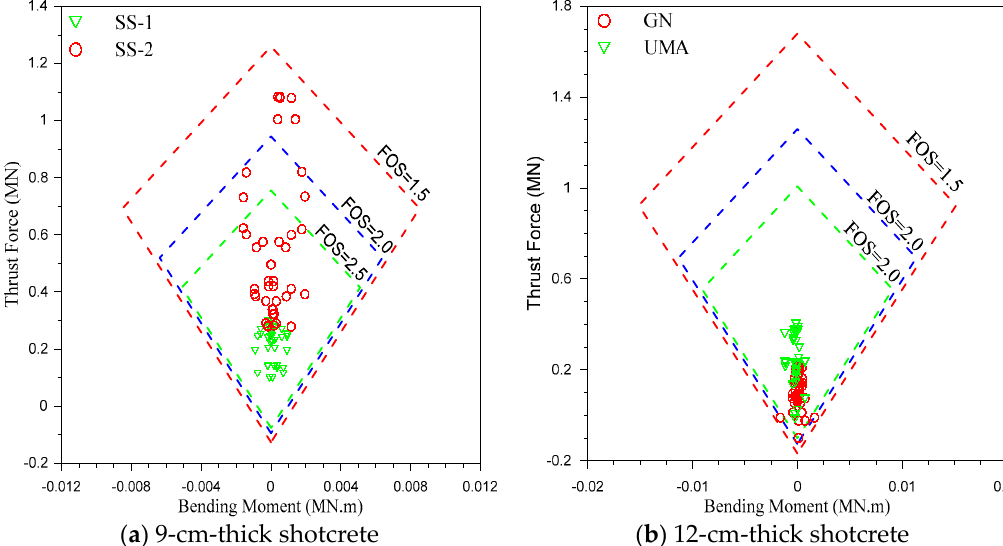
Figure 10. Extent and number of plastic zones around the Project 6 tunnel before and after support.